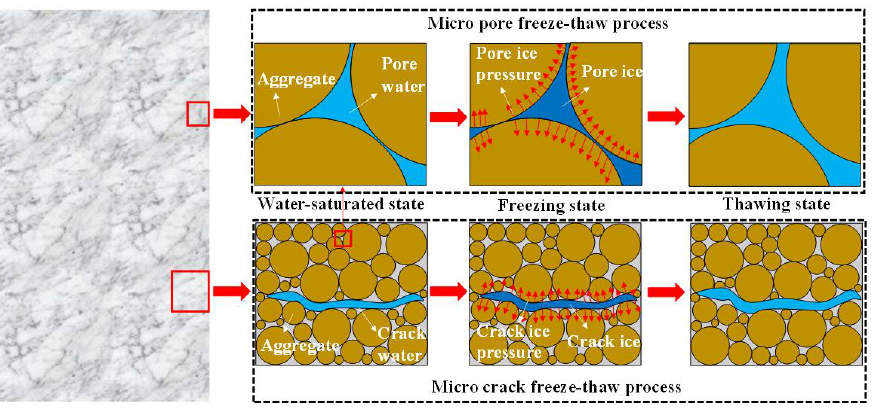
Figure 6. Propagation and development of pores and cracks under freeze-thaw cycles.